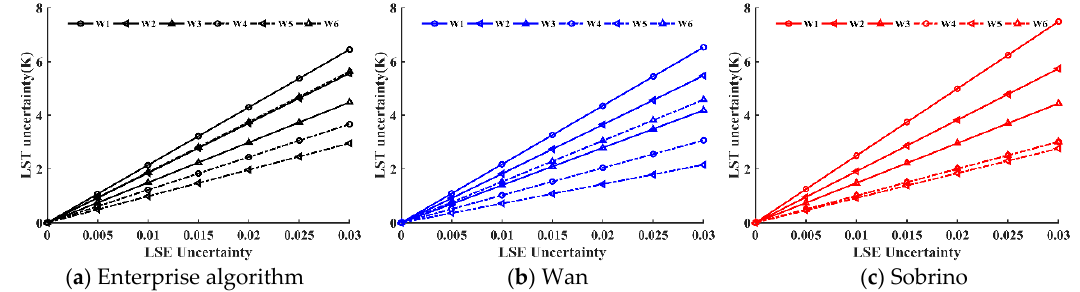
Figure 4. LST uncertainty attributed to the emissivity uncertainty at six water vapor content subranges. The mean emissivity was set as 0.96. The emissivity uncertainty was set from 0 to 0.03 with a step of 0.005. W1–W6 are the atmospheric water vapor range (W1 = 0.0–2.5 cm; W2 = 2.0–3.5 cm; W3 = 3.0–4.5 cm; W4 = 4.0–5.5 cm; W5 = 5.0–7.0 cm, and W6 = 0.0–7.0 cm).